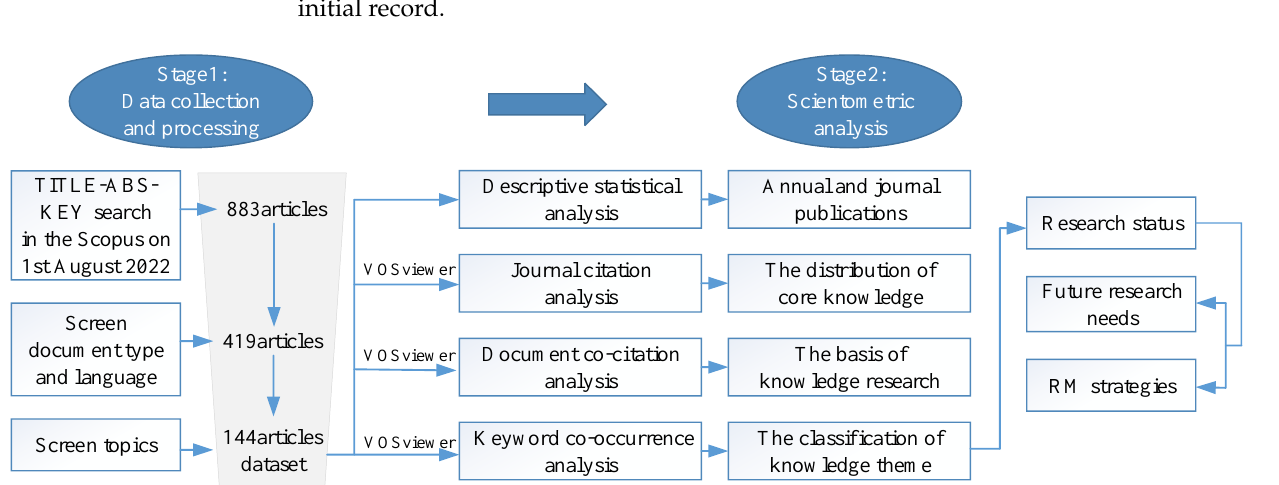
Figure 1. The methodological process.